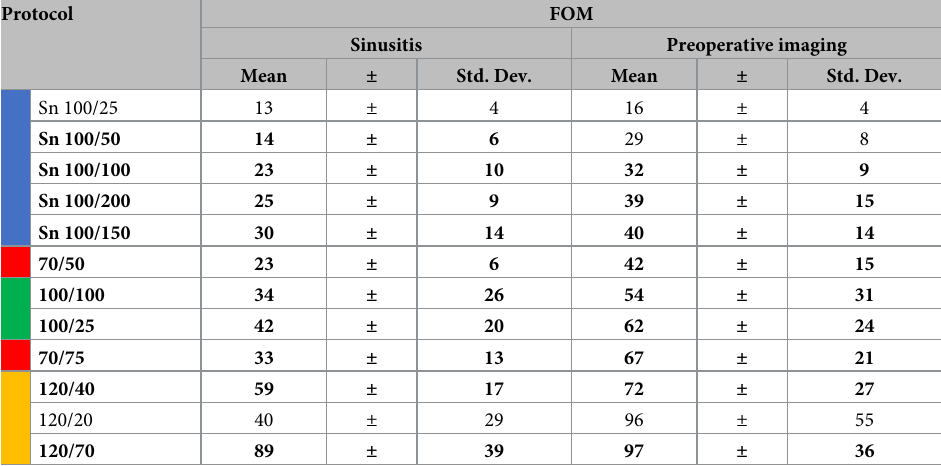
The lower the value, the better the result. Only values in bold fulfill the required image quality for diagnosing sinusitis and preoperative planning. Protocols are ranked from top to bottom according to the preoperative planning FOM results from best to worst. Protocols are color coded based on their tube voltage and tin filtration. Red = 70 kV, green 100 kV, yellow = 120 kV and blue = Sn 100 kV. FOM = figure of merit, Std. Dev. = standard